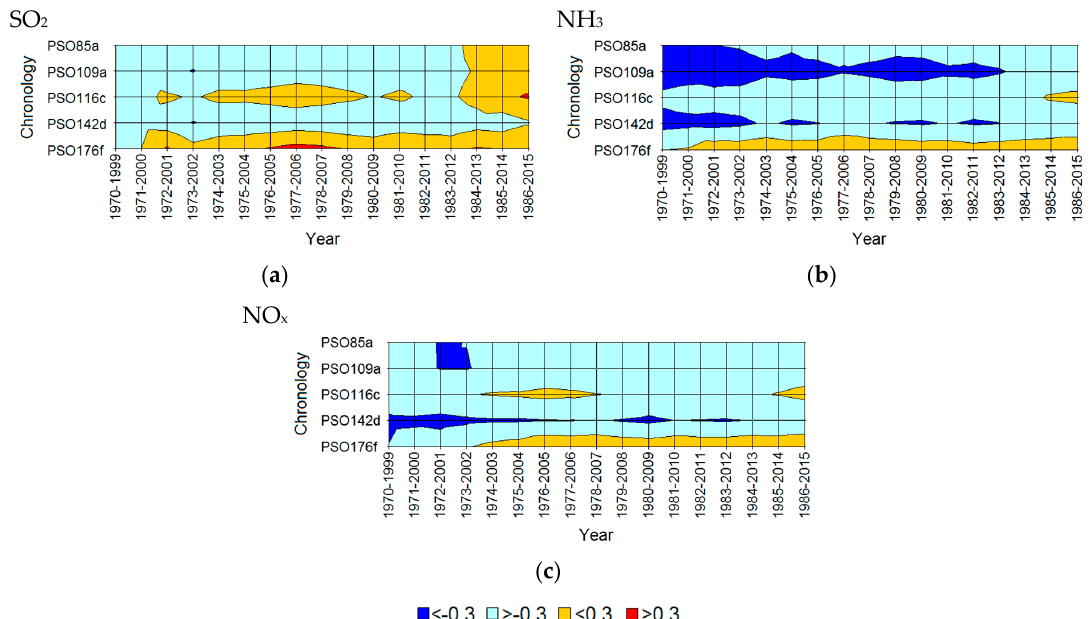
Figure 9. The moving correlation analysis for the relation of Scots pine residual chronologies and the emission of gaseous air pollutants SO 2 ( a ), NH 3 ( b ), NO x ( c ) from the emitters of Zakłady Azotowe Puławy 1970–2015. Notes: The Pearson’s correlation coefficient at α ≤ 0.1 and for N = 30 is ± 0.296, where N is the number of degrees of freedom.